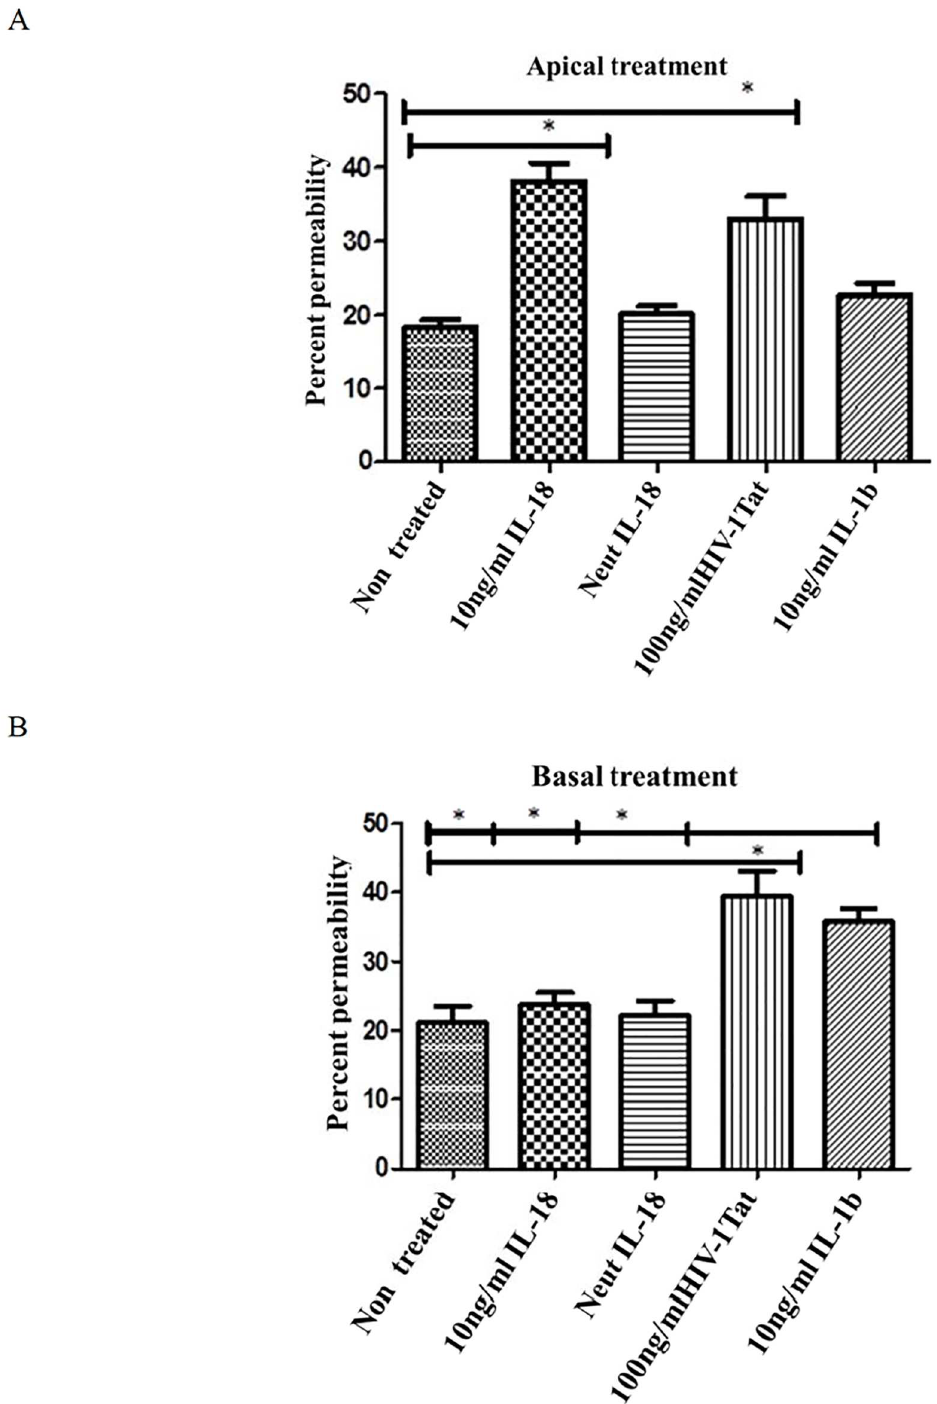
Fig 11. IL-18 increases paracellular permeability when applied to the apical surface. HT-29 cells were grown in monolayers in Transwell chambers. When confluent, IL-18 (10 ng /ml), IL-1 β (10 ng/ml) or Tat (100 ng/ml) were applied to the apical surface (A ) or to the Transwell bottom wells ( B ). In one well, we added IL-18 pre-neutralized with anti-IL-18 antibody. After 24 hours’ exposure, Lucifer Yellow (0.45 kDa; 100 nM) was added to the top wells. After 30 minutes, the Transwell upper chambers were removed, and the concentrations of the fluorescent tracer were measured in bottom wells in an ELISA reader. Percent permeability was determined by comparing the tracer in the